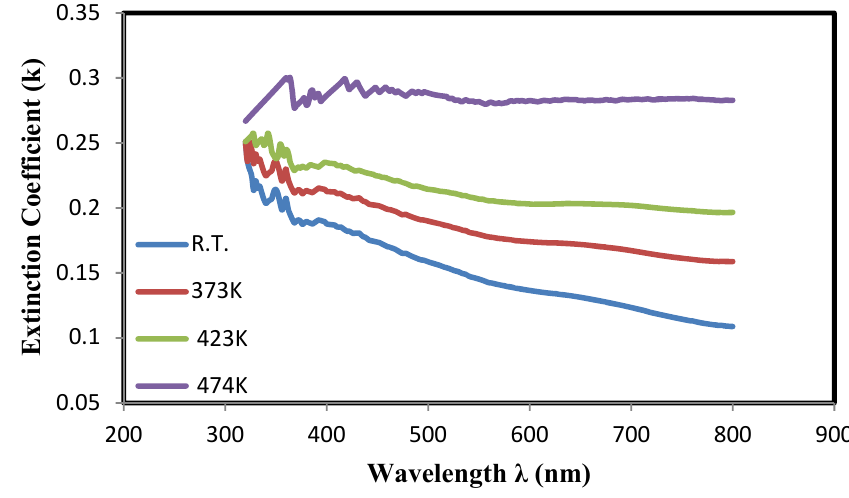
Fig. 6: The variation of extinction coefficient with wavelength for NiO